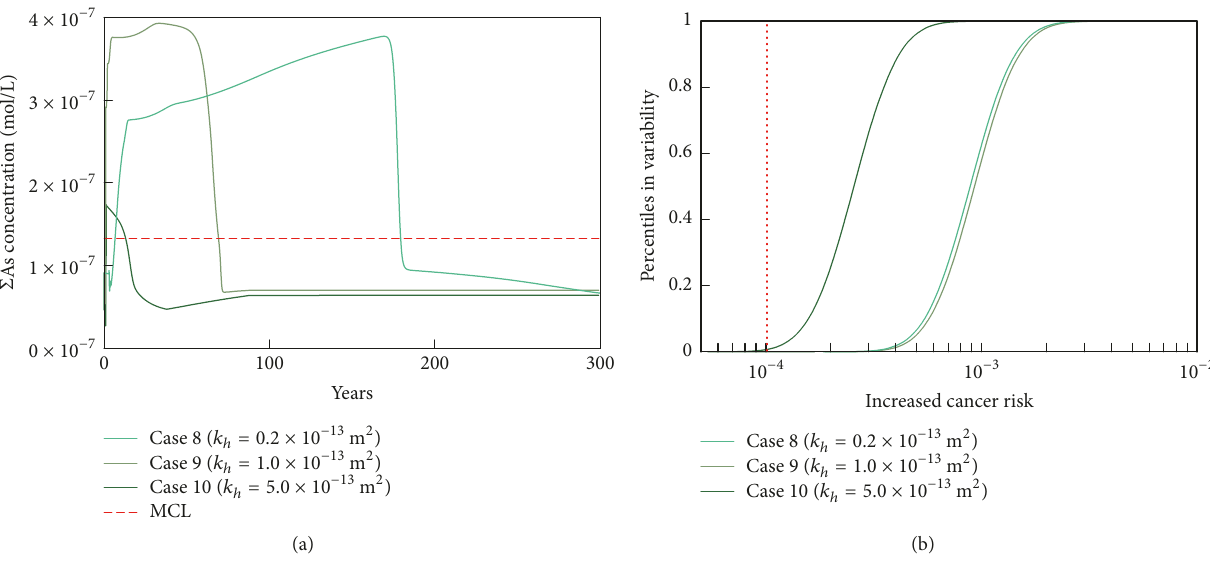
Figure 14: (a) ∑ As profiles with different horizontal permeabilities ( 𝑘 ℎ ) of 0.2 × 10 −13 , 1.0 × 10 −13 , and 5.0 × 10 – 13 m 2 (Cases 8–10) and (b) probabilistic health risk for Cases 8–10 plotted as cumulative density functions (CDF). The red dotted line represents the risk level of concern (10 −4